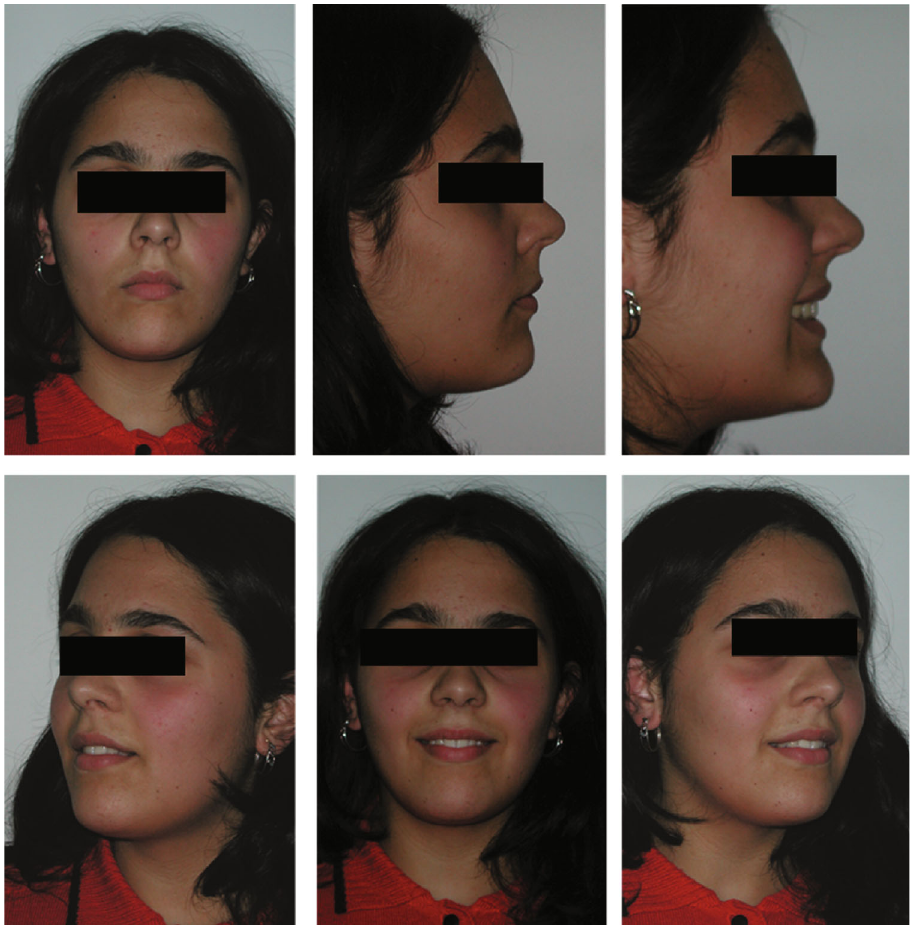
Figure 9: 2-years follow-up extraoral